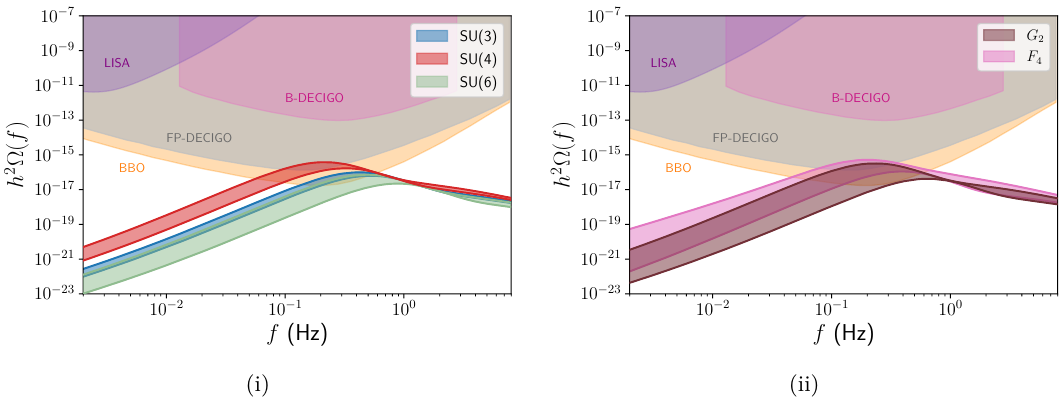
Figure 7. The resulting GW spectra for (i) SU( N ) with N = 3 , 4 , 6 and (ii) G 2 , F 4 for the choice T v = 100 GeV, g v = 100 . The critical temperature in each case can be obtained from eq. (4.12) ∗ ∗ as T c ≈ 158 , 135 , 109 , 137 and 99 GeV repectively for SU(3), SU(4), SU(6), G 2 and F 4 . This is of the same order as the dark confinement scale T c ∼ Λ , although the exact relationship depends on the gauge group and requires lattice calculations (see footnote 5). The uncertainty comes mostly from the different choices of good fits for SU( N ) and of states q c and q t in the case of G 2 and F 4 . The value of the dark coupling constant at the critical temperature is taken to be in the range 0 . 2 ≤ α s ( T c ) ≤ 0 . 4 , which also contributes to the